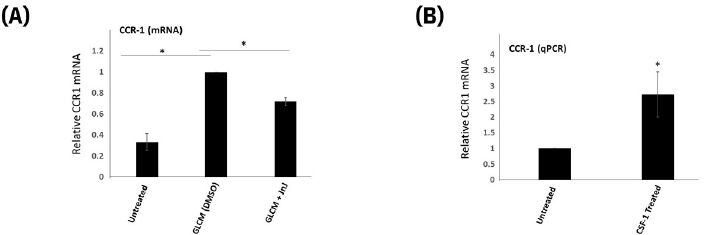
Figure 4. CCR1 expression is downstream of CSF1R. ( A ) quantitative PCR was performed on MG cells treated with GL261 conditioned media for 4 HRs in the absence and presence of the CSF-1R inhibitor JnJ using primers specific for CCR1. ( B ) MG cells were treated for 24 h with recombinant hCSF1 (10 ng/mL) and level of CCR1 mRNA was quantitated using qPCR. * p value < 0.05. Data are mean − /+ SEM (n = 3).